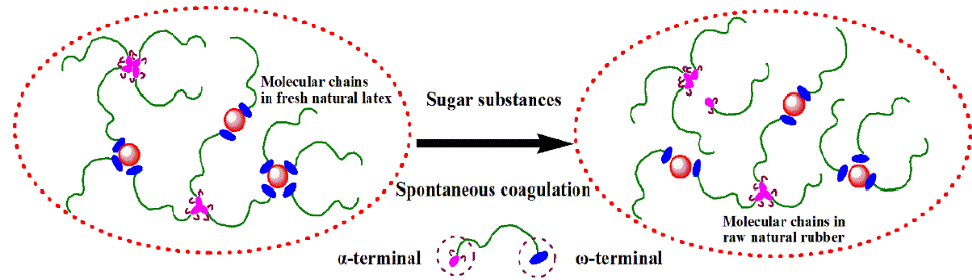
Figure 3. Schematic illustration of the possible decomposition of crosslinking points between the terminals of the natural rubber molecular chains.